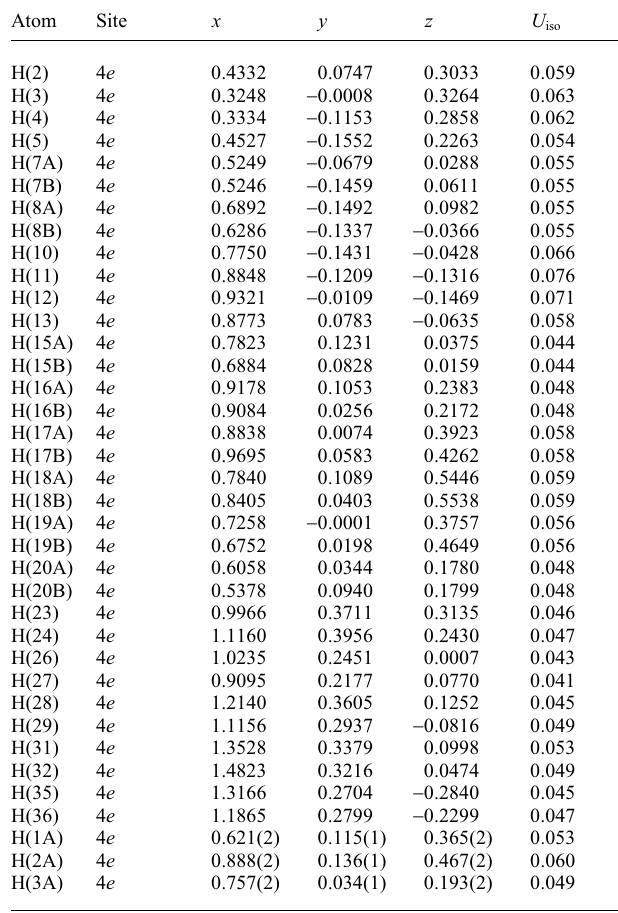
Table 2. Atomic coordinates and displacement parameters (in Å 2 )